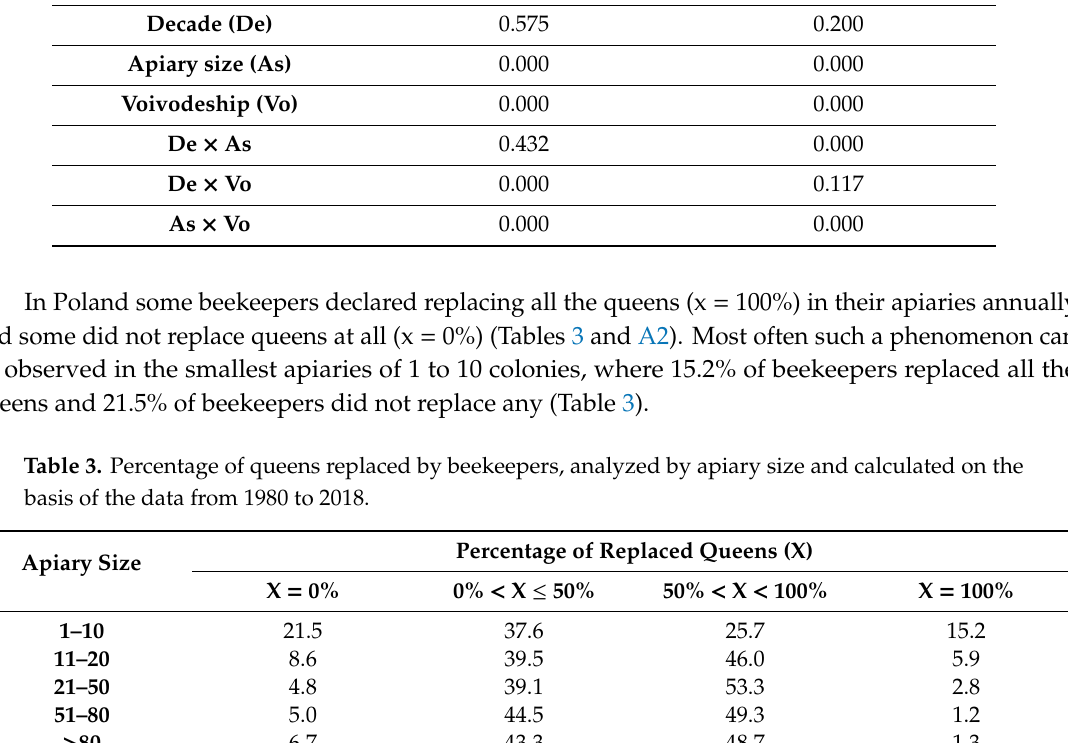
Table 2. Probability of Wald χ 2 test statistic for the tested classification for beekeepers and their interaction in generalized linear models (GLMs) estimated for investigated dependent variables. Beekeepers E ff ect Replacing Queens Purchasing Queens Decade (De) 0.575 0.200 0.000